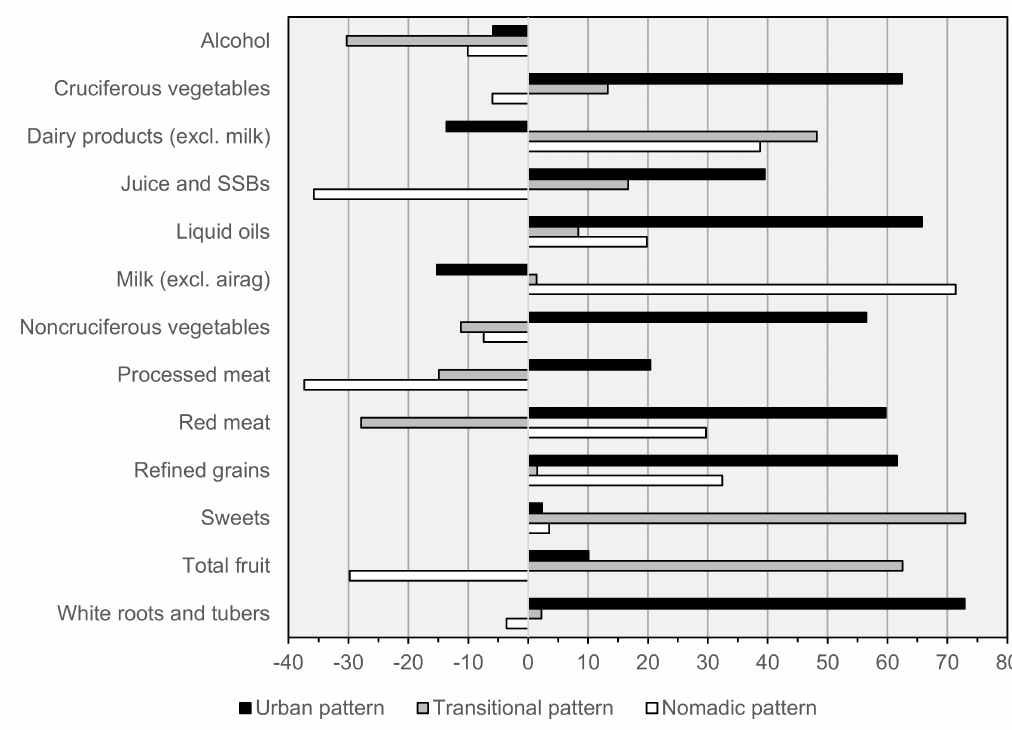
Figure 2. Diet pattern factor loadings. Urban, Transitional, and Nomadic diet patterns account for 20.5%, 10.9%, and 9.8% of variation in intake of pattern components, respectively (total: 41.1%). Factor loadings are generated using annualized average intakes for 334 participants (based on 1834 diet record days); used to calculate season-specific patterns scores for each participant; and seasonal pattern scores are scaled from 0–100. Airag: fermented mares’ milk, SSBs: sugar-sweetened beverages. Table 7. Mean diet pattern scores by subgroup-season and province. Urban Pattern Score Transitional Pattern Score Nomadic Pattern Score Stratum Mean SE Mean